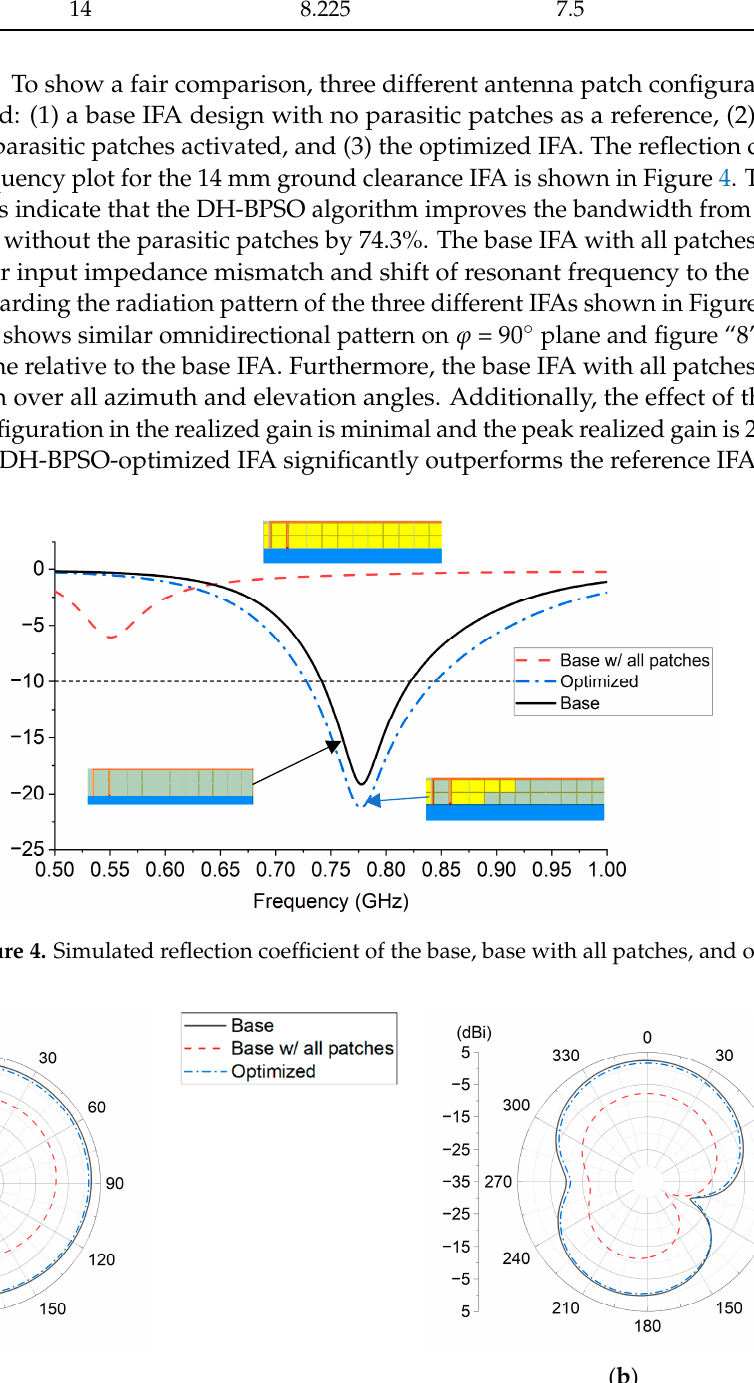
( f ) Figure 6. Optimized patch configurations for ground clearances of ( a ) 9 mm, ( b ) 10 mm, ( c ) 11 mm, ( d ) 12 mm, ( e ) 13 mm, and ( f ) 14 mm.